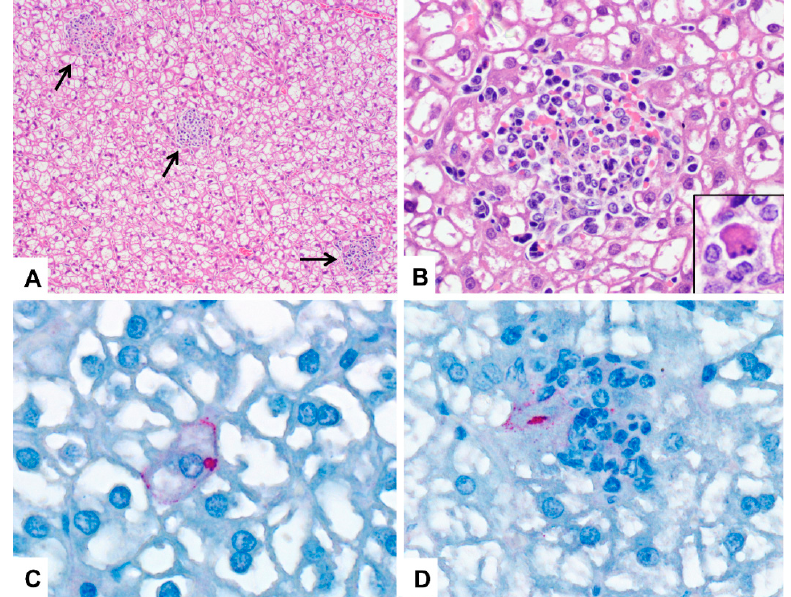
Figure 3. Photomicrographs of liver from Marburg-virus inoculated Egyptian rousette bats; DPI = days post-infection. ( A ) Liver, 6 DPI. Randomly scattered foci of mixed cellular infiltrate disrupt the liver parenchyma (arrows) in a bat with a liver histologic score of 4 (see text for lesion scoring). There is also diffuse glycogen-type hepatocellular vacuolation. HE stain; original magnification: 100×. ( B ) Liver, 6 DPI. Higher magnification of (A) showing a focus of mixed inflammation with karyorrhectic debris and mild hemorrhage. HE stain; original magnification 600×. Inset: higher magnification of a necrotic hepatocyte in an adjacent liver inflammatory focus. HE stain; original magnification 1000x. ( C ) Liver, 7 DPI. Immunohistochemical stain showing perimembranous and cytoplasmic Marburg virus antigen (red) in a hepatocyte. Immunoalkaline phosphatase with naphthol fast red and hematoxylin counterstain; original magnification: 630×. ( D ) Liver, 5 DPI. Marburg virus antigen (red)